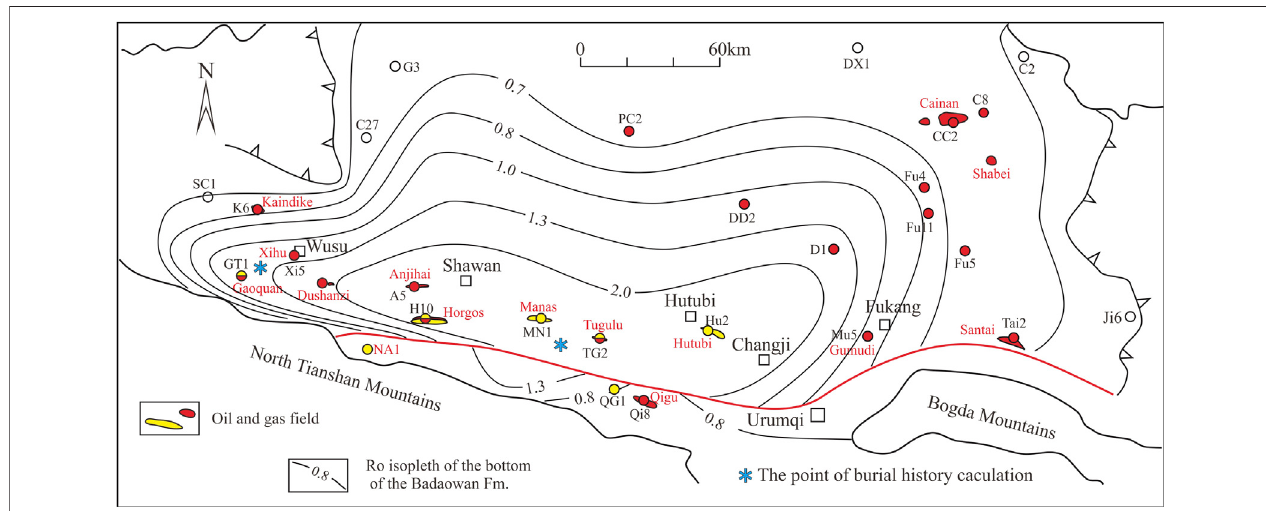
FIGURE6| MaturityofsourcerocksatthebottomofJurassicandthedistributionmapofmainoilandgas fi elds(wells)fromJurassicinsouthernmarginofJunggar Basin.